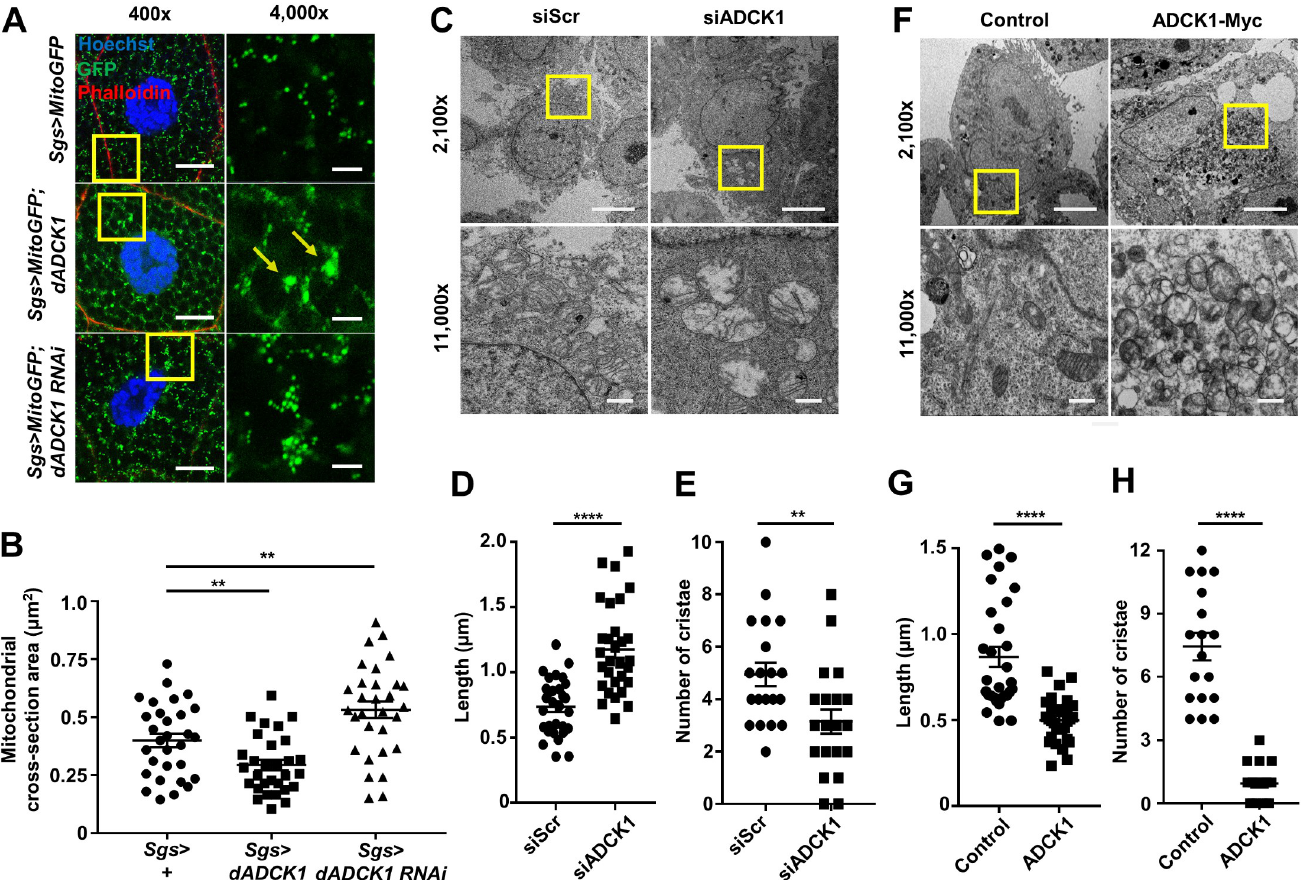
Fig 5. ADCK1 controls mitochondrial structures. (A) Fluorescent confocal microscopy images for the salivary glands of the third instar larvae with indicated genotypes. MitoGFP (green) shows mitochondria and phalloidin (red) staining indicates the cell boundary. Hoechst (blue) was used for nuclei staining. Scale bars, 20 μ m (400 × ) and 5 μ m (4,000 × ). Boxed areas were enlarged as shown on the right panels. Arrows direct clustered mitochondria. (B) Comparison of the mitochondrial cross-section area in the salivary glands of the third instar larvae with indicated genotypes. n = 30. �� , p < 0.01 by unpaired t-test. (C) TEM images of HeLa cells transfected with scramble siRNA (Scr) or siADCK1 as indicated. The boxed areas were enlarged in the bottom panels. Scale bars, 5 μ m (2,100 × , top) and 500 nm (11,000 × , bottom). (D) Comparison of the mitochondrial length in HeLa cells transfected with siScr or siADCK1. n = 30. ���� , p < 0.0001 by unpaired t-test. (E) Comparison of the number of mitochondrial cristae in HeLa cells transfected with siScr or siADCK1. n = 20. �� , p < 0.01 by unpaired t-test. (F) TEM images of HeLa cells expressing empty vector or ADCK1-Myc as indicated. Scale bars, 5 μ m (2,100 × , top) and 500 nm (11,000 × , bottom). The boxed areas were enlarged in the bottom panels. (G) Comparison of the mitochondrial length in controls and HeLa cells transfected with ADCK1. n = 30. ���� , p < 0.0001 by unpaired t-test. (H) Comparison of the number of mitochondrial cristae in controls and HeLa cells transfected with ADCK1. n = 18. ���� , p < 0.0001 by unpaired t-test.